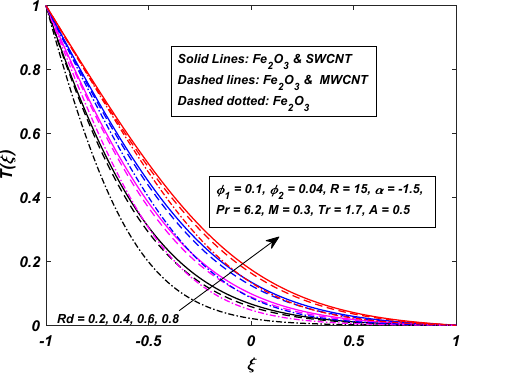
Figure 9. Influence of Rd on T ( ξ